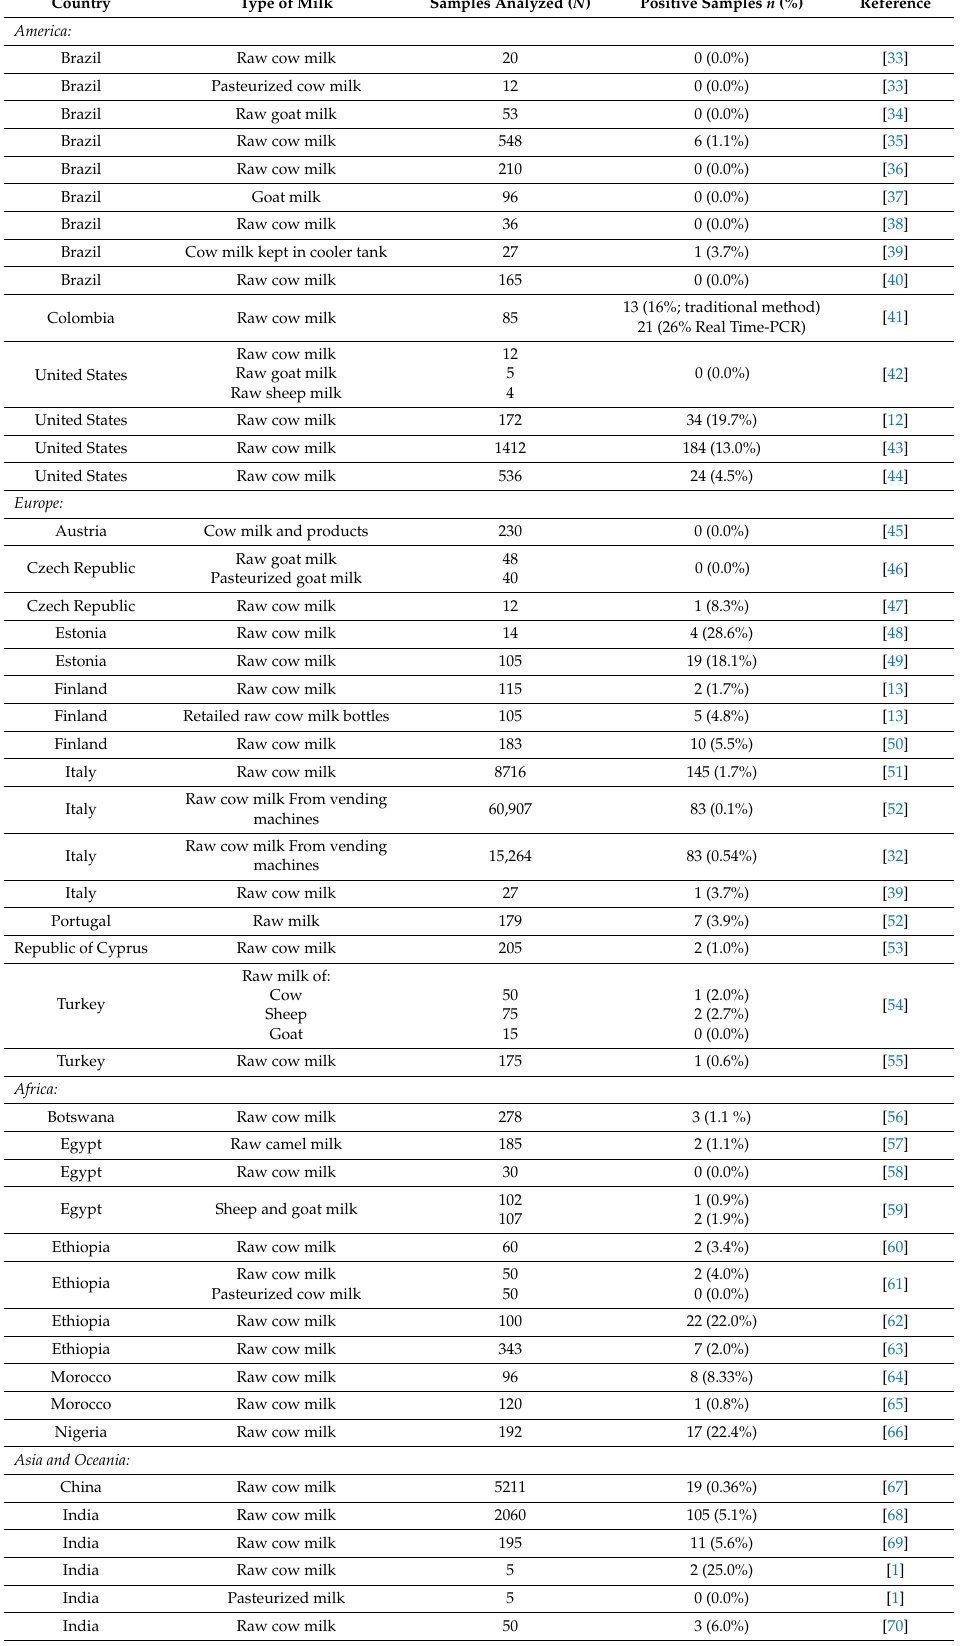
Table 1. Worldwide occurrence of Listeria monocytogenes in